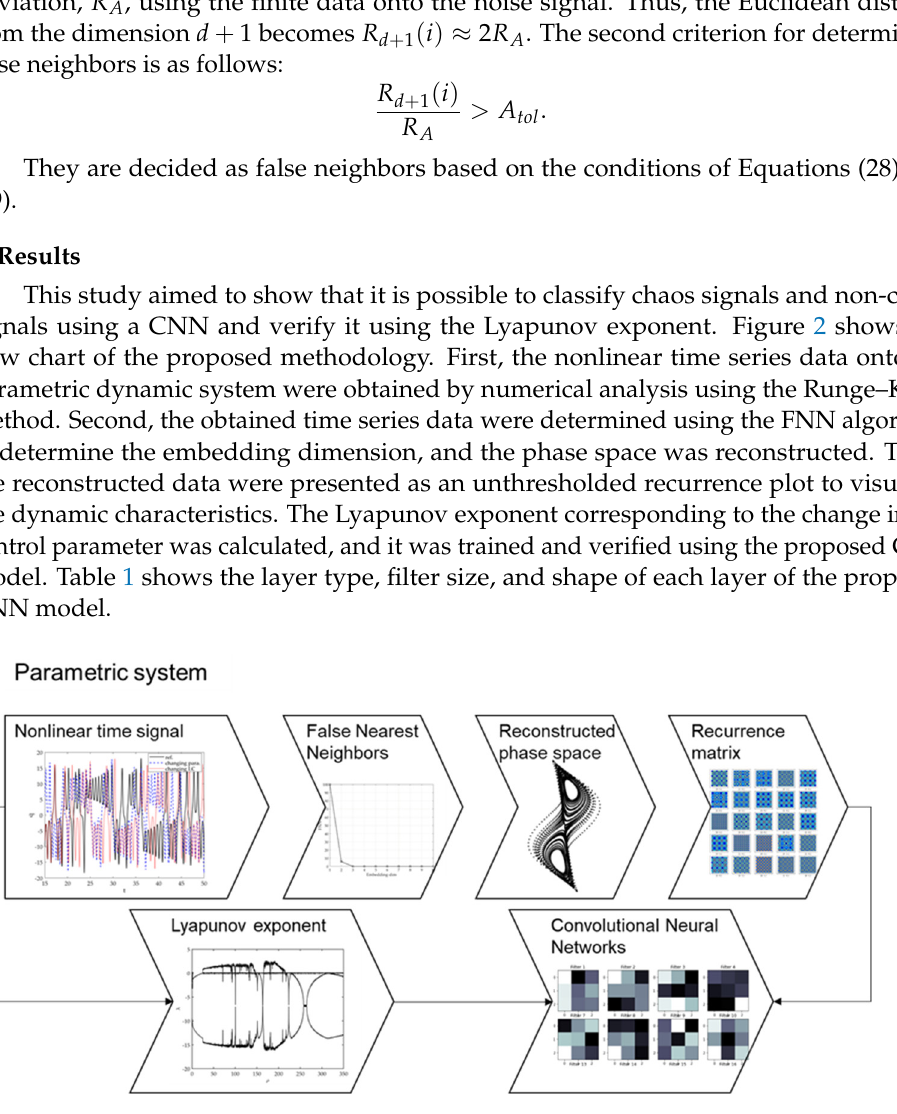
Figure 2. Flow diagram of the proposed